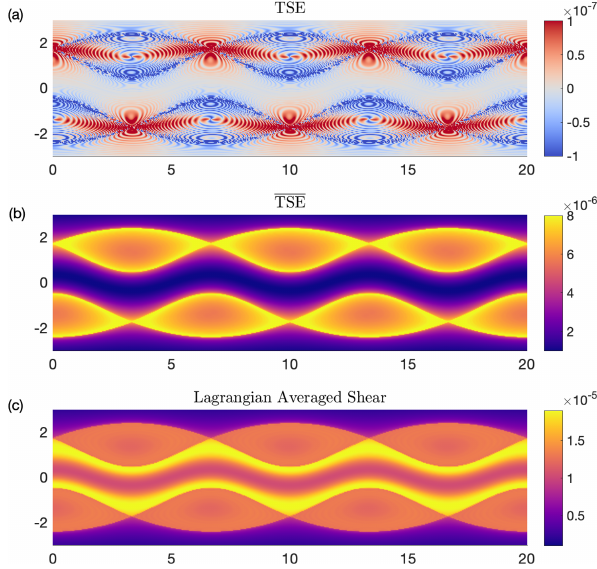
Figure A2. (a) TSE values show a complex stretch–relax pattern in the Bickley jet but still accurately identify the edges of each eddy as well as the central jet. (b) TSE contours clearly reveal the central jet and the adjacent eddies. There is limited trajectory-tangent stretch- ing in the central jet, with a slight increase near the boundaries. (c) Lagrangian-averaged shear also reveals the multiple eddies and central jet, in contrast to Eulerian shear measurements. Lagrangian- averaged divergence is omitted as it is zero